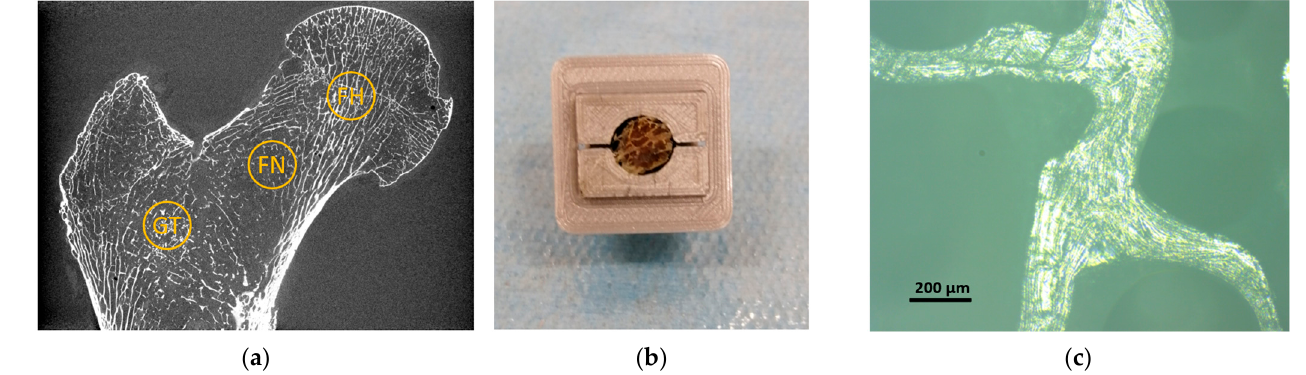
Figure 2. Sample extraction and preparation. ( a ) Localization of the three different bone regions extracted from each proximal femur, “GT” refers to great trochanter, “FN” refers to femoral neck and “FH” refers to femoral head; ( b ) trabecular sample stored in the designed sample holder after the sample preparation protocol; ( c ) optical microscopic investigation used to assess the efficacy of the preparation protocol before the microindentation assays.